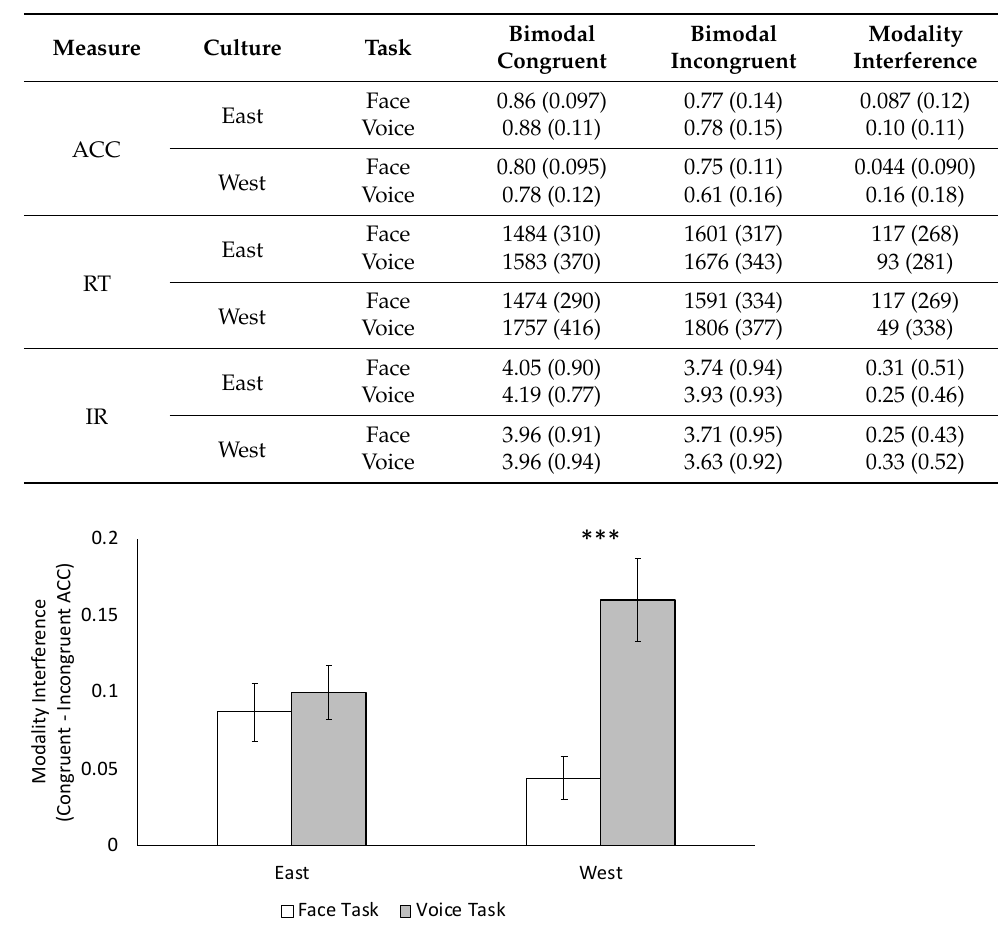
Table 2. Mean accuracy rates (ACC), response times in ms (RT), and intensity ratings (IR) across cultures, tasks, and conditions (standard deviations are in parentheses).